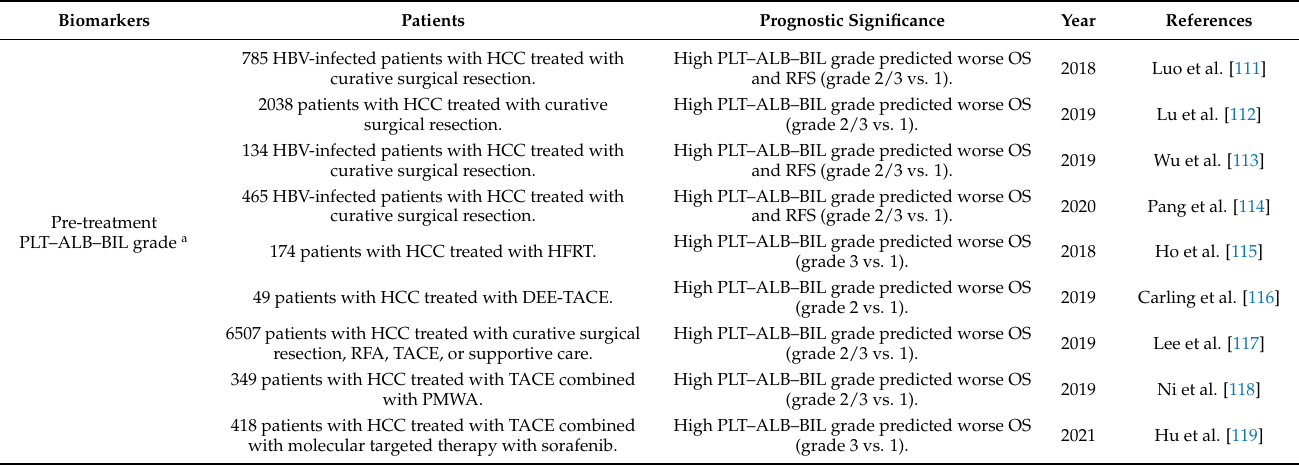
Table 6. Prognostic significance of serum PLT–ALB–BIL grade in HCC